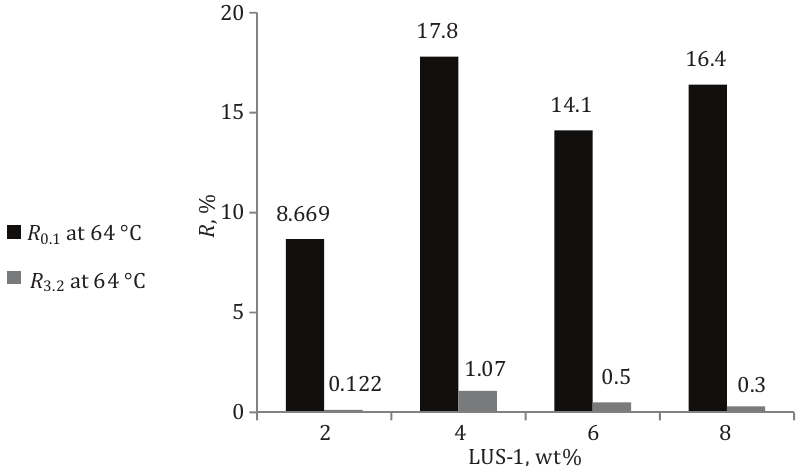
Figure 16. Effect of stress levels on recovery percent of asphalt binders at 64